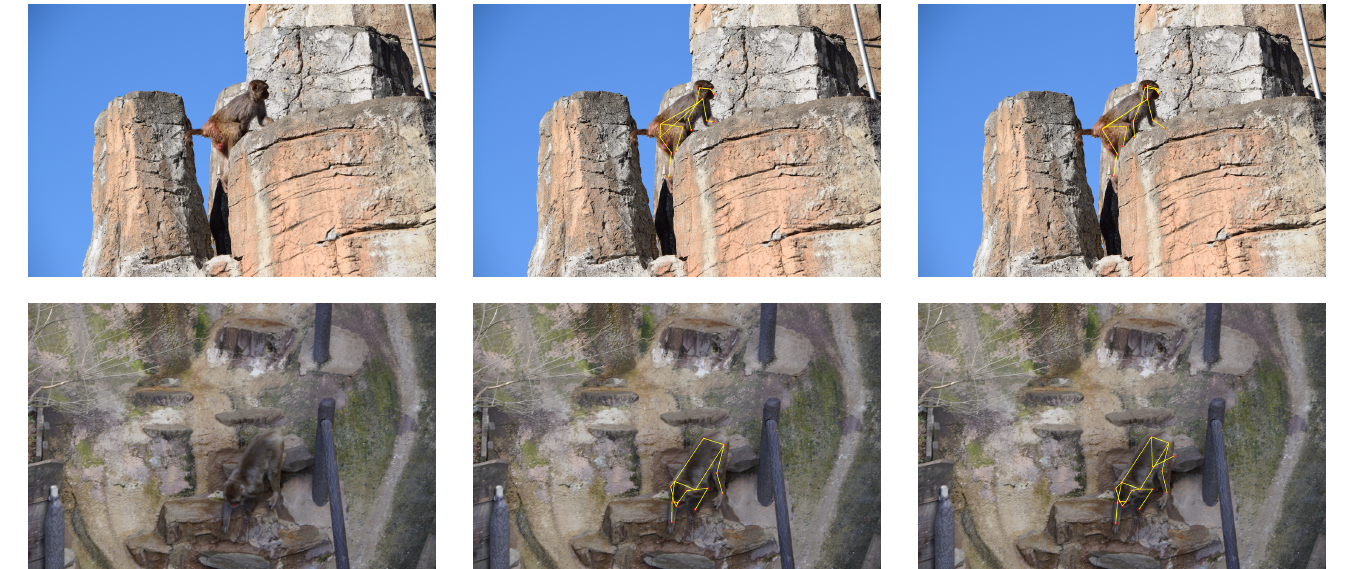
Figure 6. The results of pose estimation. The images in the left most column are original images, those in the middle colummn are manually annotated, and those in the right most column are annotated by